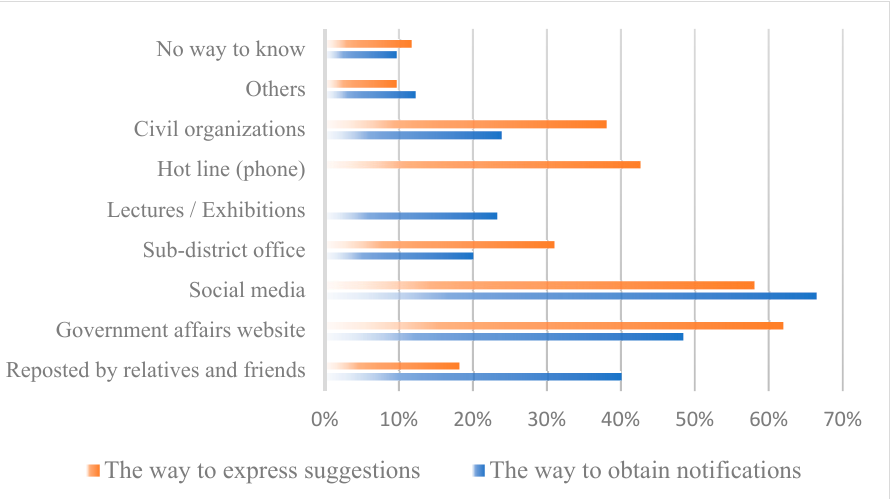
Figure 7. The channels to receive notifications from the government and to express suggestions from the residents.